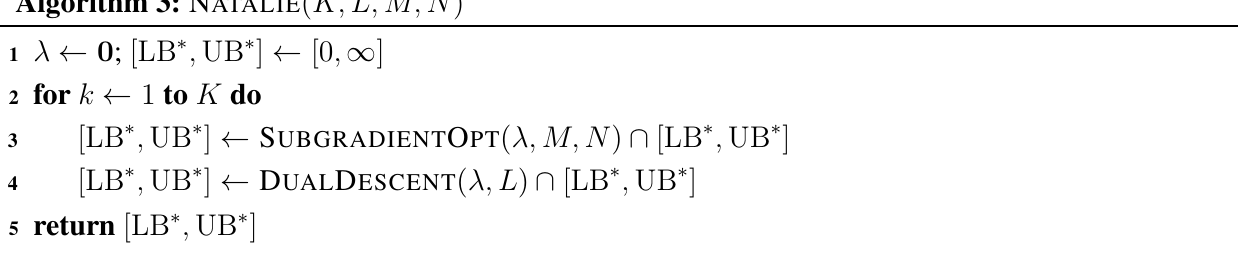
Algorithm 3: N ATALIE ( K, L, M, N